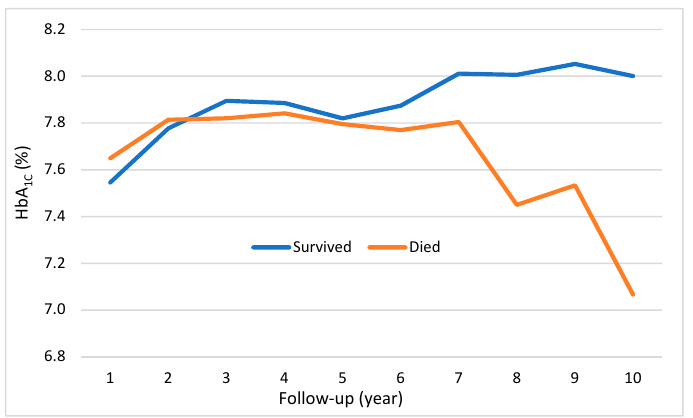
Figure A1. The mean values of HbA 1C throughout the follow-up (by follow-up year) among patients who died and among survivors.